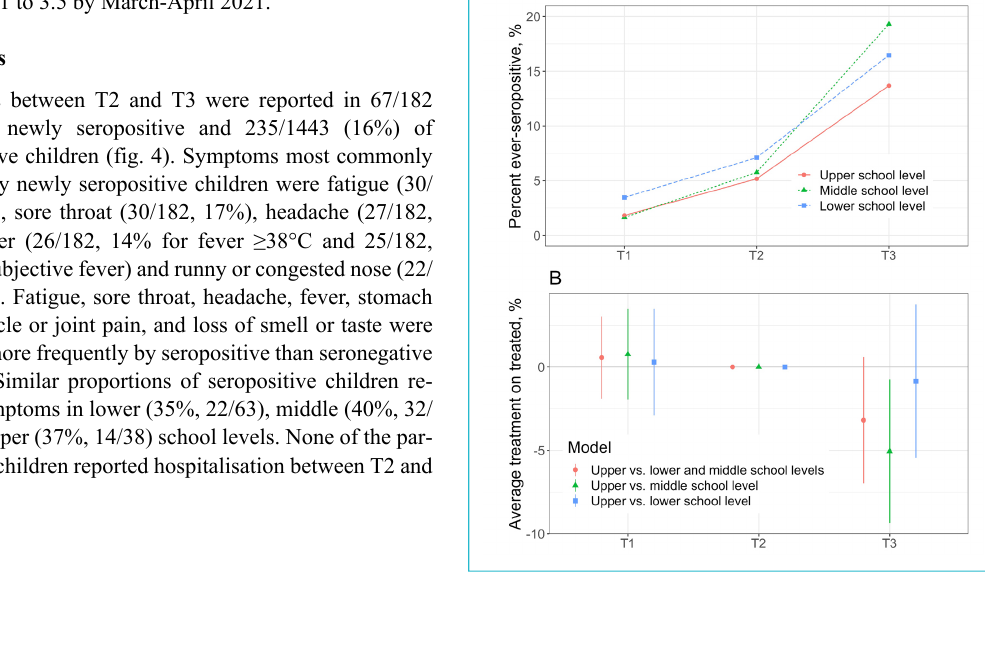
Figure 4: Symptoms reported between October-November 2020 and March-April 2021 in children who were seronegative and newly seroposi- tive at T3 (March-April